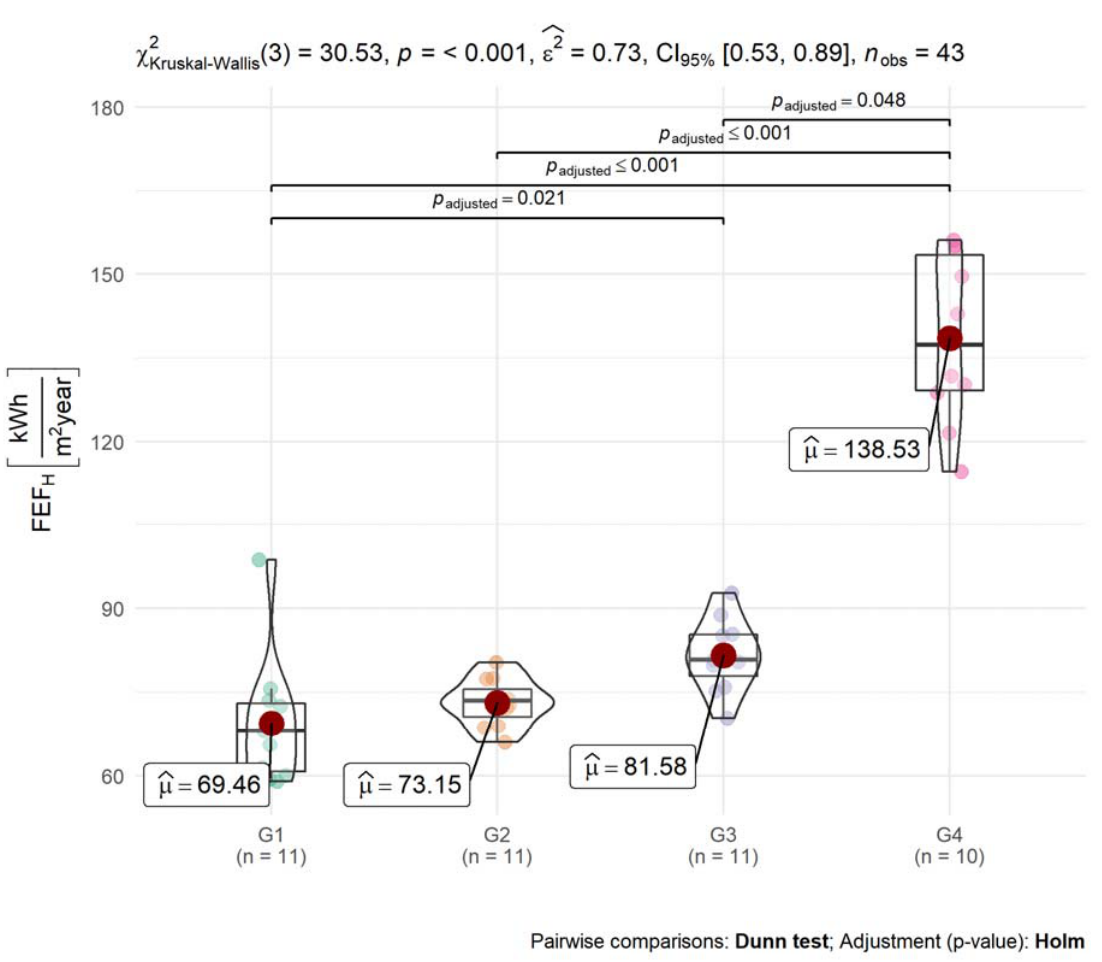
Figure 5. Comparison of annual final energy consumption factor ( FEF H ).